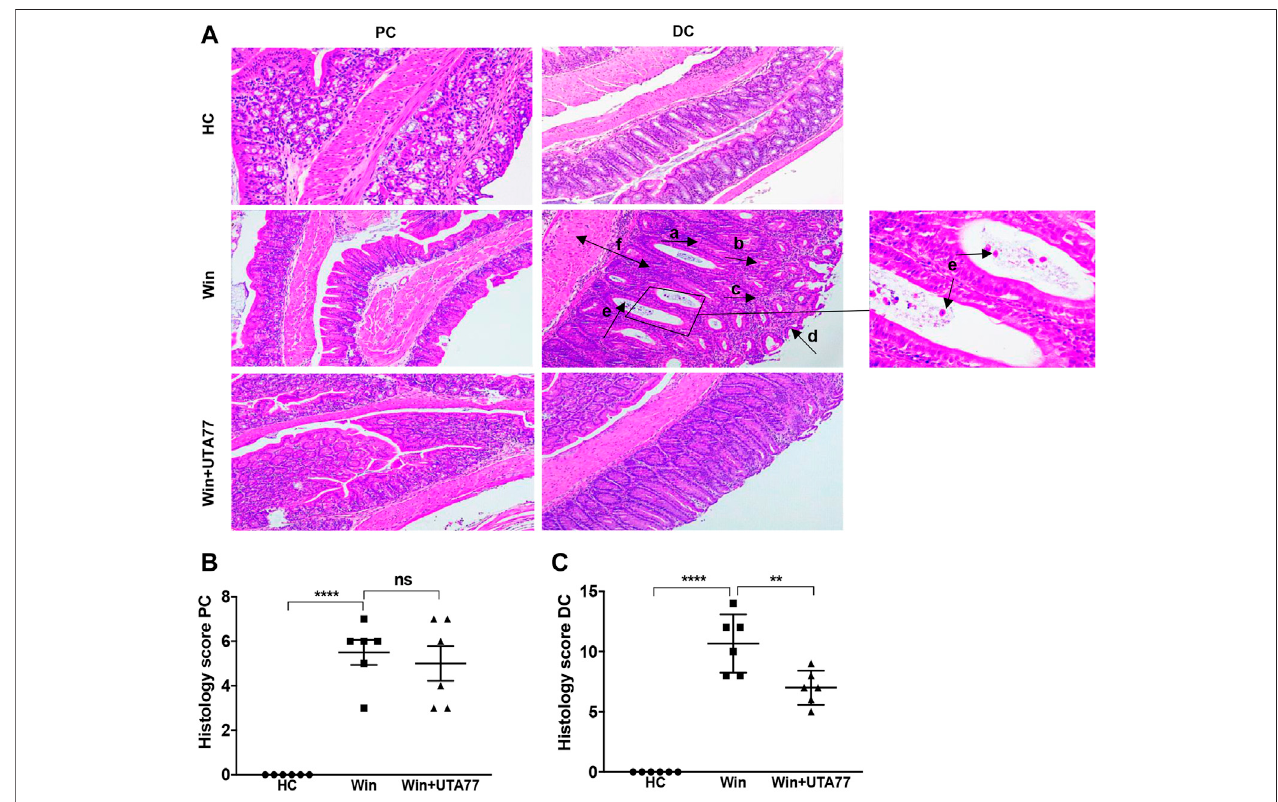
FIGURE 8 | Effect of UTA77 on histopathology in spontaneous chronic colitis in Winnie mice. (A) Histological representation of PC and distal colon (DC) sections stainedwithH&E forhealthymice (HC), Winnie controlmice (Winnie),and Winnie plus UTA77-treatedmice (Winnie +UTA77) at × 10magni fi cation. (B) and (C) represent the histopathology scores for each animal calculated after microscopic analysis of tissue sections from the PC and DC. Statistical signi fi cance among groups was evaluated by one-way ANOVA followed by Tukey ’ s posttest. **p < 0.01, ****p < 0.0001, and ns: nonsigni fi cant. Data expressed as mean ± SEM ( n (cid:1) 6/group). Arrows indicate goblet cells loss (a), crypts loss/crypts distortion (b), in fl ammatory cells in fi ltration (c), epithelial surface erosion (d), crypt abscesses (e), and mucosal/ submucosal oedema (f).